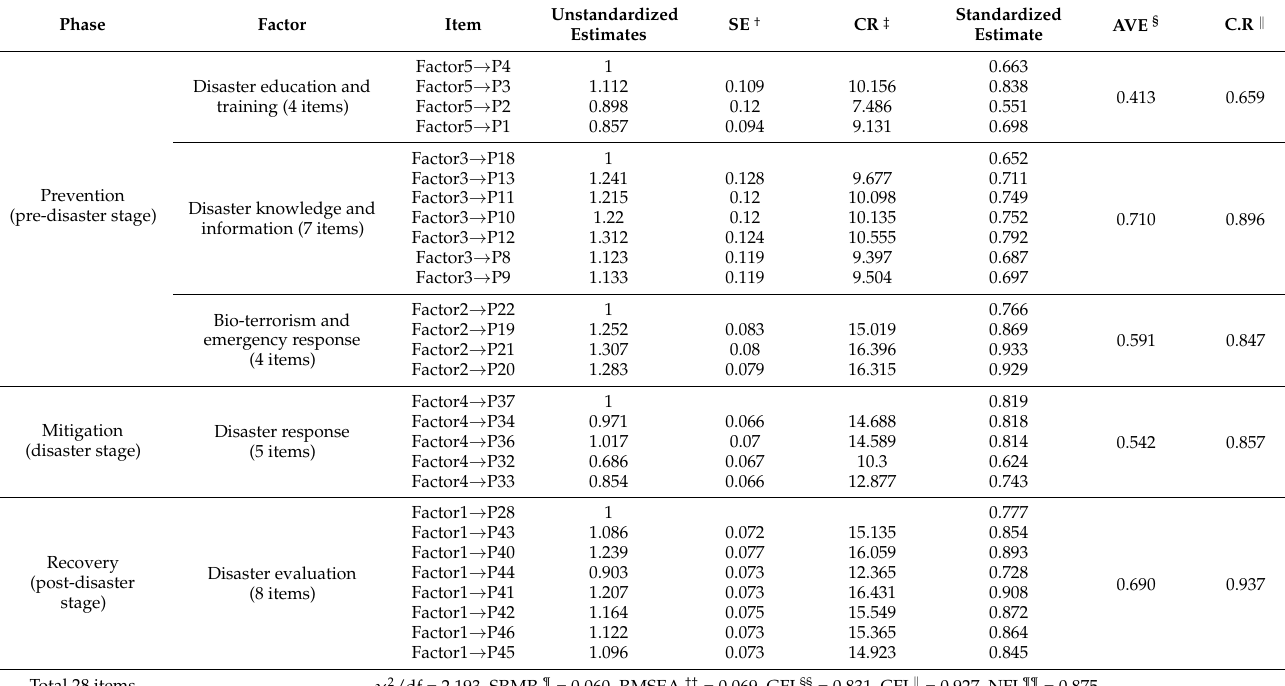
Table 3. Convergent validity and model fitness according in the confirmatory factor analysis ( N = 249). Phase Factor Item Unstandardized Estimates SE † CR ‡ Standardized Estimate AVE § C.R